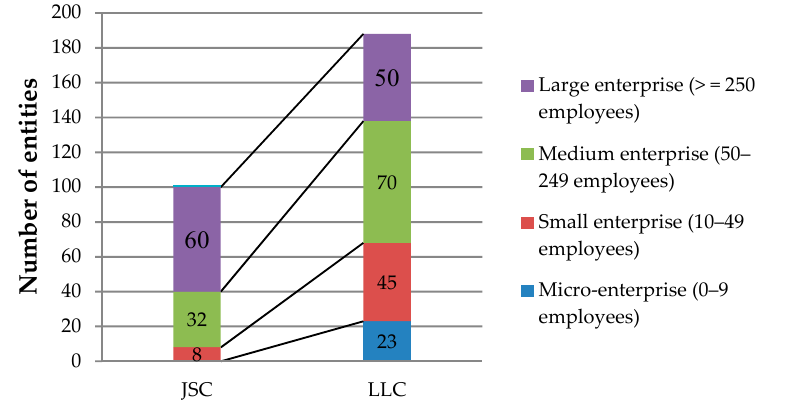
Figure 2. Classification of economic entities.